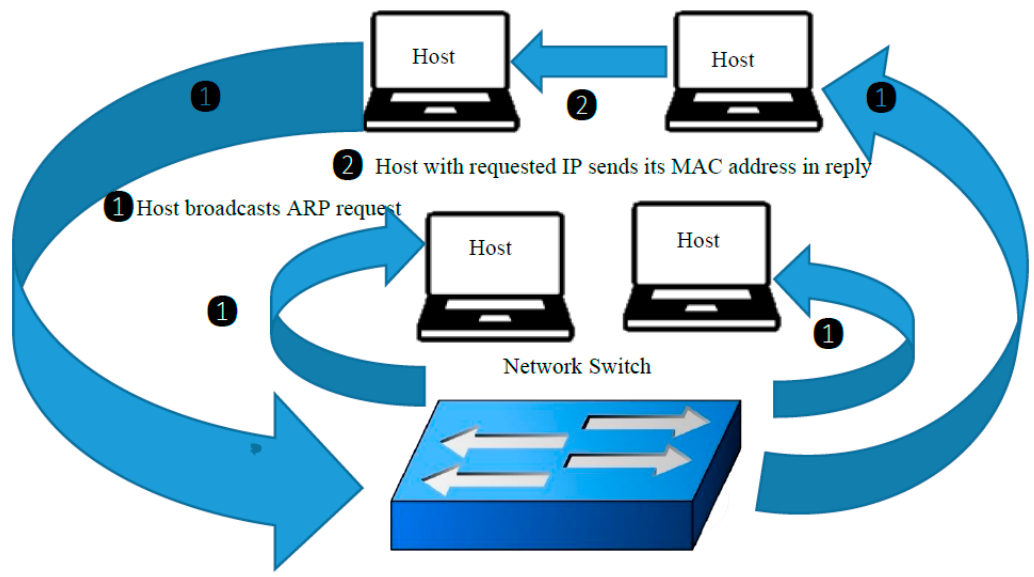
Figure 1. ARP (Address Resolution Protocol) in Traditional Networks.